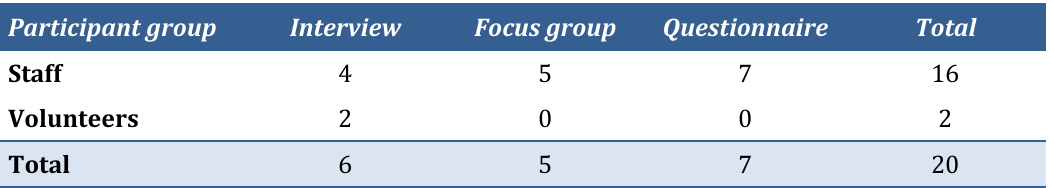
Table 1: Study participants by data collection methods Participant